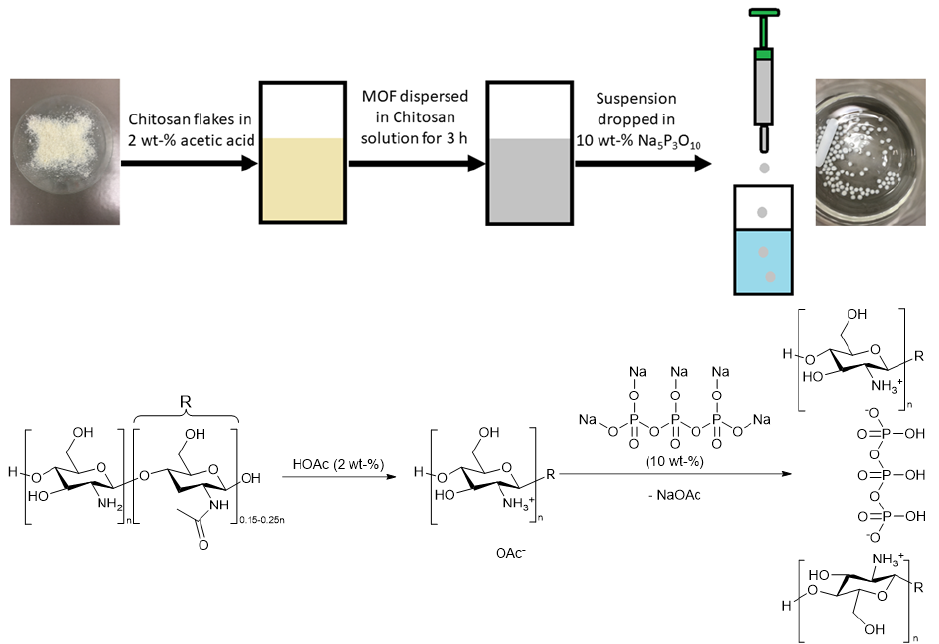
Figure 2. Synthesis process of the MOF@chitosan composites and reaction scheme of the crosslinking process below (both with Na 5 P 3 O 10 ).